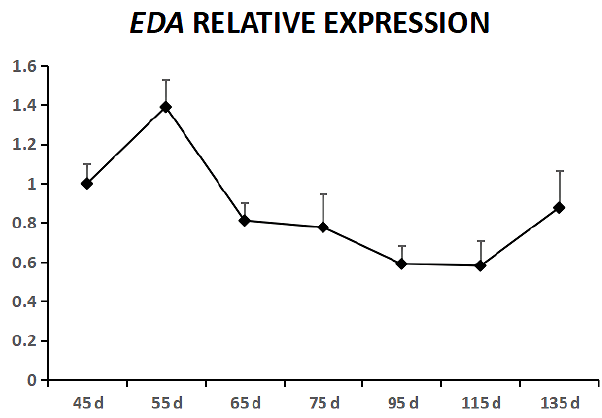
Figure 2. Relative expression levels of the EDAR gene during the fetal